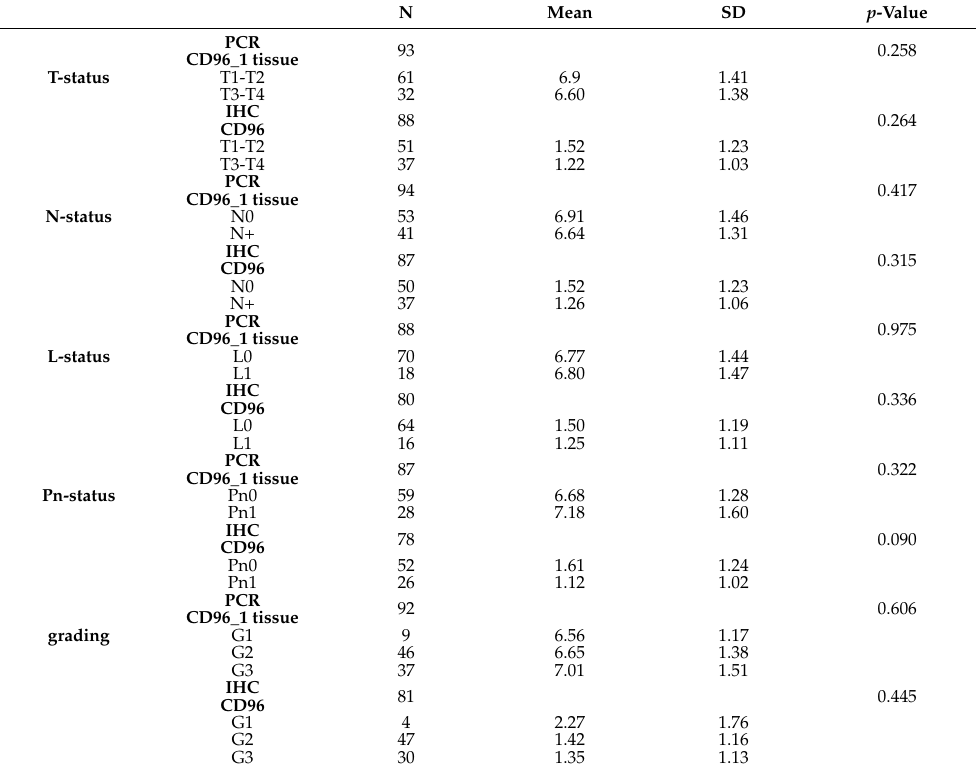
Table 4. CD96 expression in tissue of OSCC patients related to histomorphological parameters. (T-, N-, L-, Pn-status, grading). The association with the CD96 expression in tissue specimens of the patient group to histomorphological parameters (T-, N-, L-, Pn-status, grading) is shown in Table 4. The samples were analyzed via RT-qPCR and IHC. Displayed are the mean ∆ CT value (mean) for RT-qPCR and the labelling index (mean) for IHC, the standard deviation (SD). The p-value was determined by the Mann–Whitney U test. Higher labelling indices (LI) indicate a higher CD96 expression, whereas higher ∆ CT values indicate a lower CD96